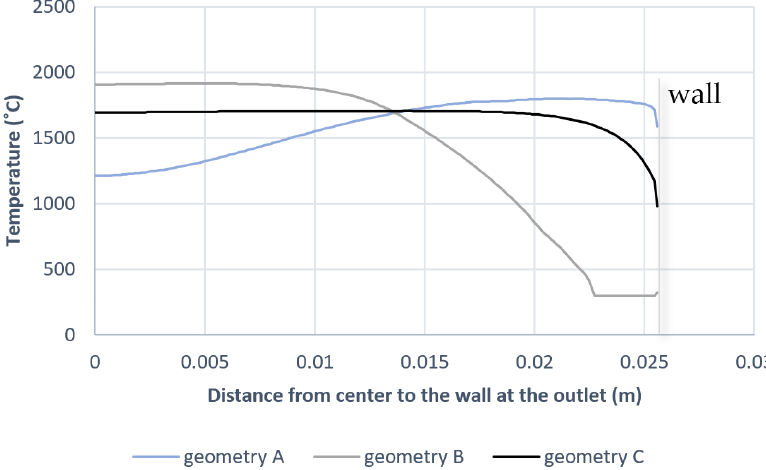
Figure 6. Temperature distribution along the outlet boundary (shown in Figure 5(C2)) for three geometry cases; A, B, and